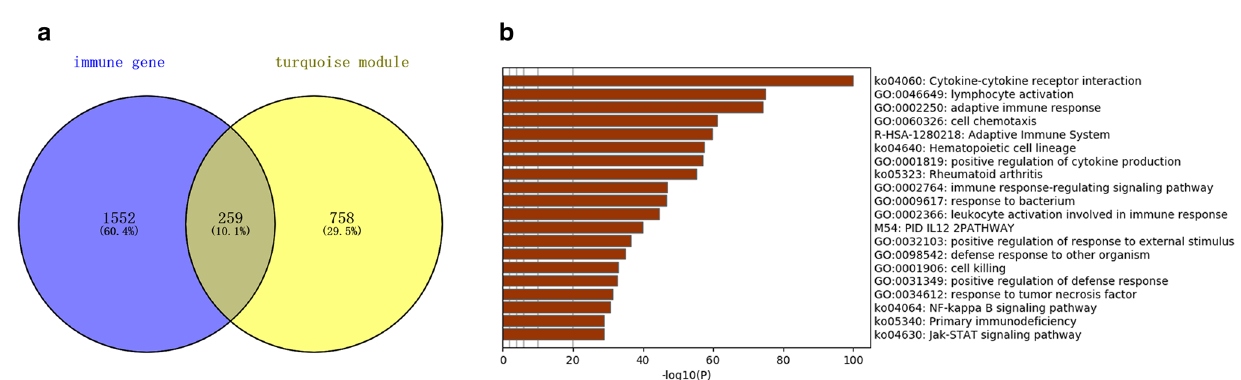
Figure 2. IRMGs identification and enrichment analysis. ( a ) 259 IRMGs (overlapping area) screened out by intersection of 2498 IRGs (circle at left) and 1017 MGs (circle at right). ( b ) The top 20 enriched clusters in